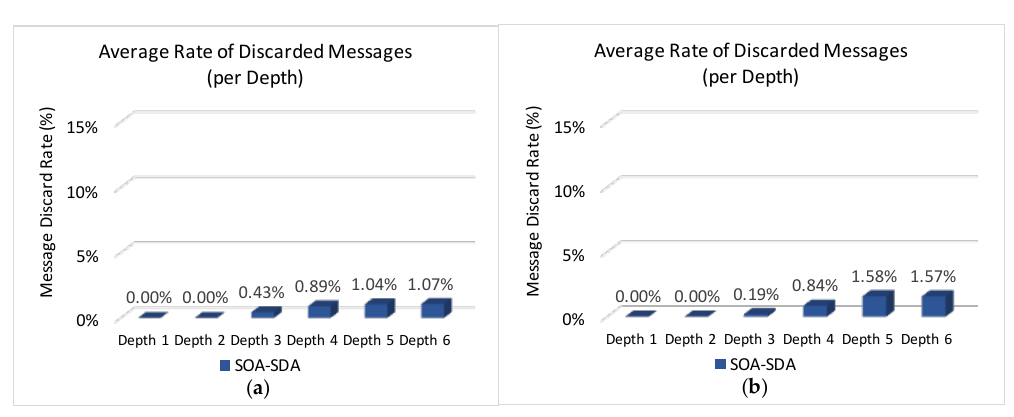
Figure 16. Average message discard rate (per depth) due to buffer overflows for the SOA-SDA scheme: ( a ) Unconditioned Scenario; ( b ) Conditioned Scenario.